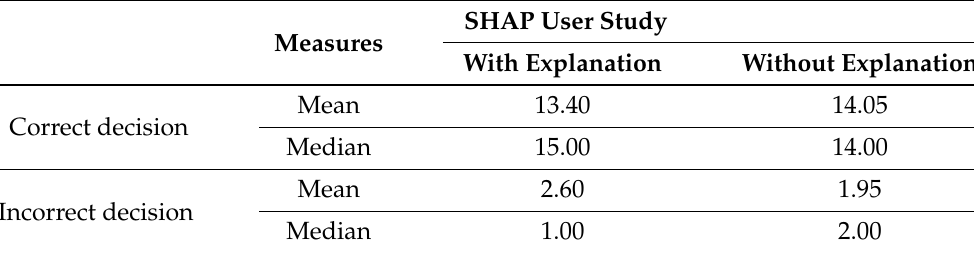
Table 7. Mean and median values of SHAP users’